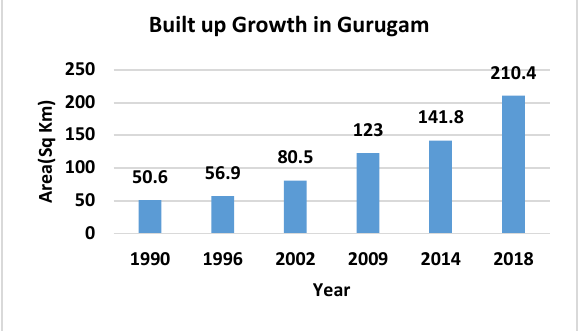
Figure 12. Bar graph showing temporal change in built-up area.